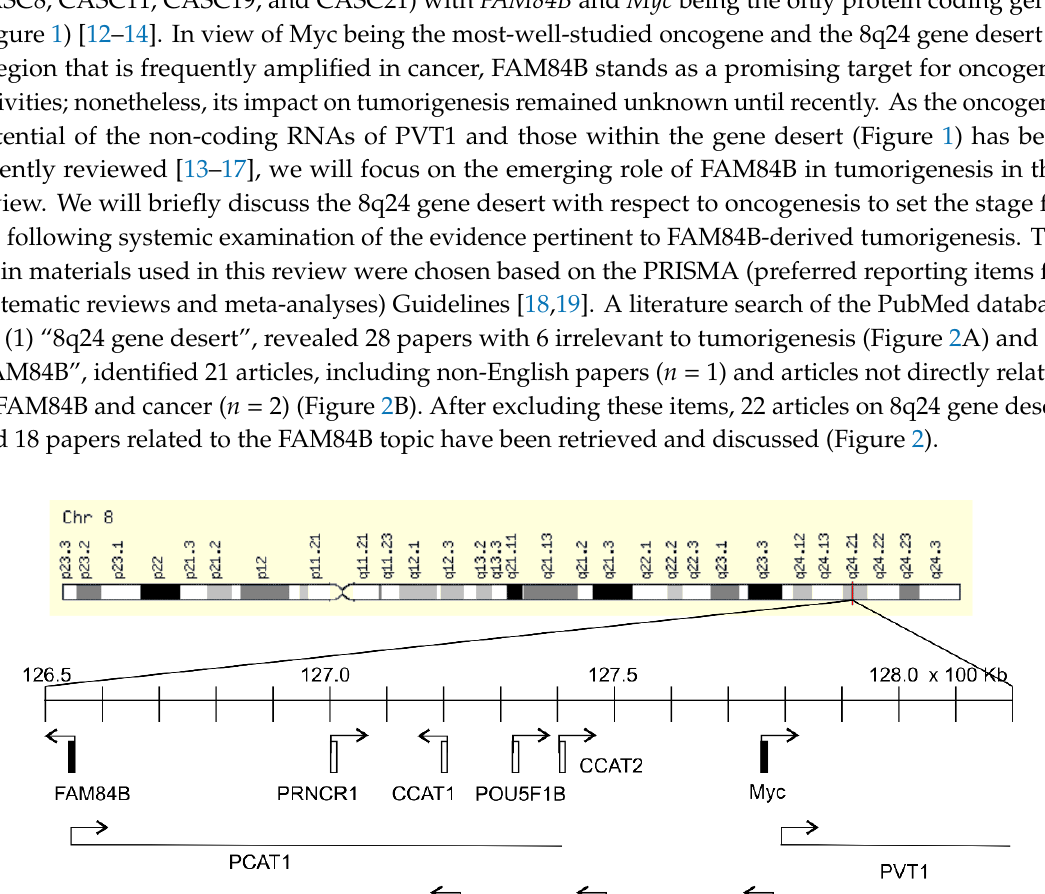
PVT1 (127,794,523-128,188,211). Among these genes, only FAM84B and Myc are protein coding genes. Among these genes, only FAM84B and Myc are protein coding genes. The gene desert region is bordered The gene desert region is bordered by FAM84B and Myc. by FAM84B and